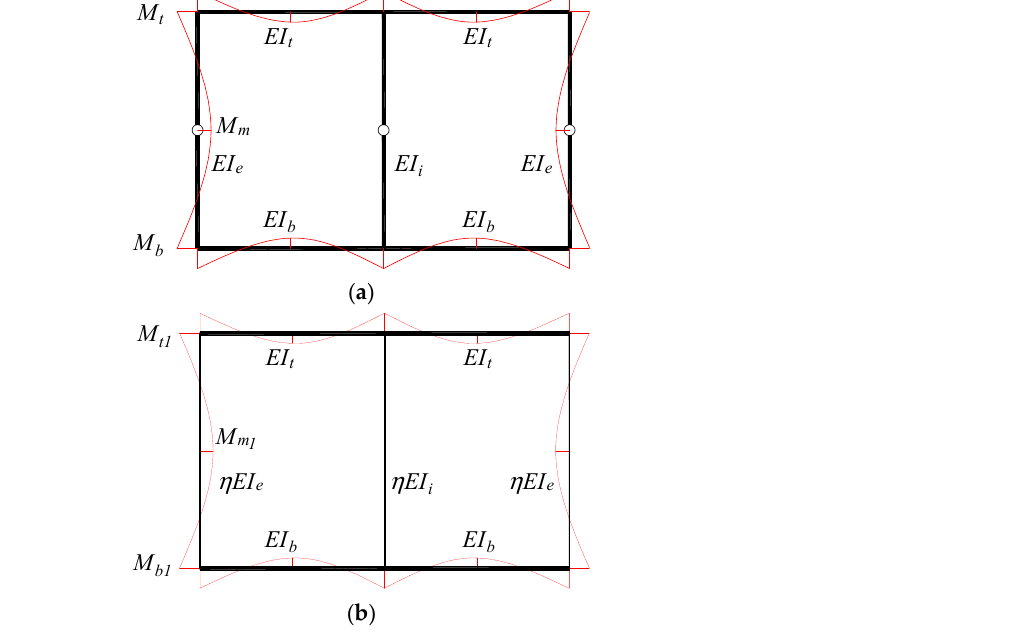
Figure 3. Bending moment diagram: ( a ) beam-spring model and ( b ) stiffness reduction model.